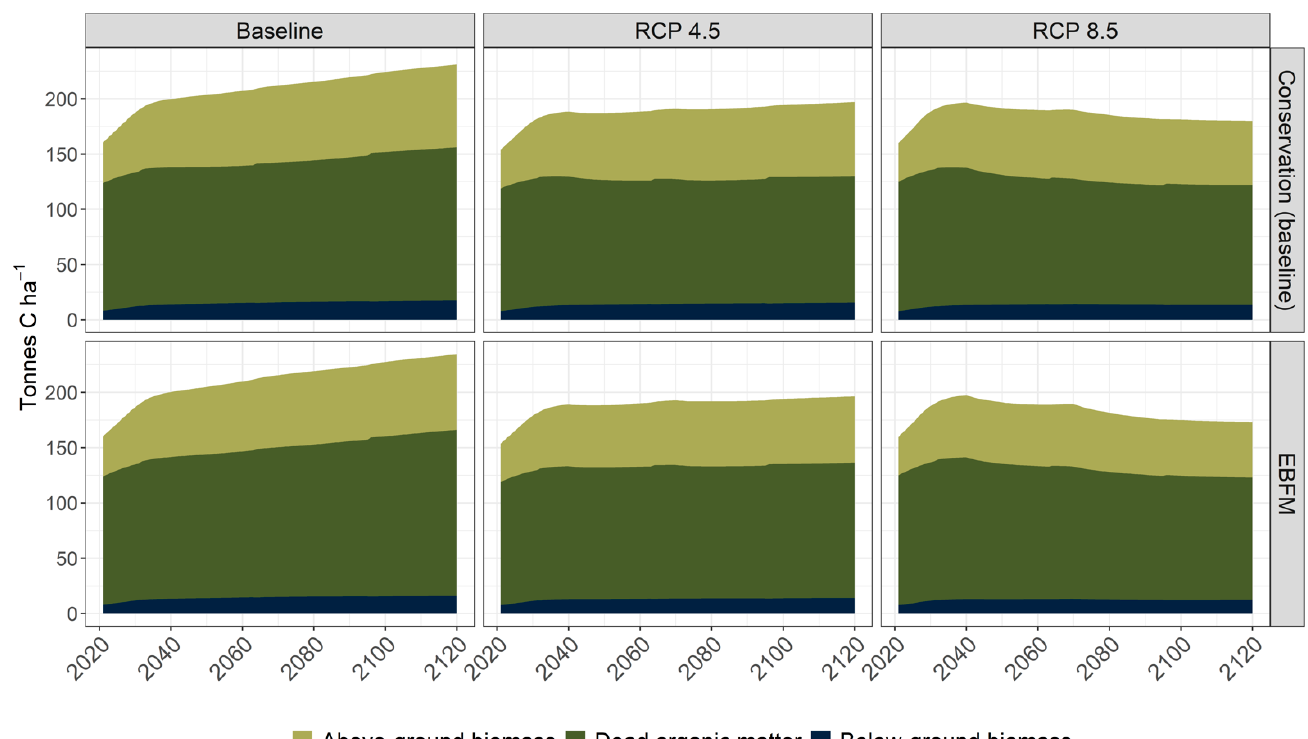
Figure 6. Carbon stocks of Maskinongé forests. Columns correspond to climate scenarios, and rows to management scenarios, i.e., conservation and ecosystem-based forest management (EBFM). Dead organic matter includes dead wood, litter, humus and mineral soil. Results are based on the average of five replicates.